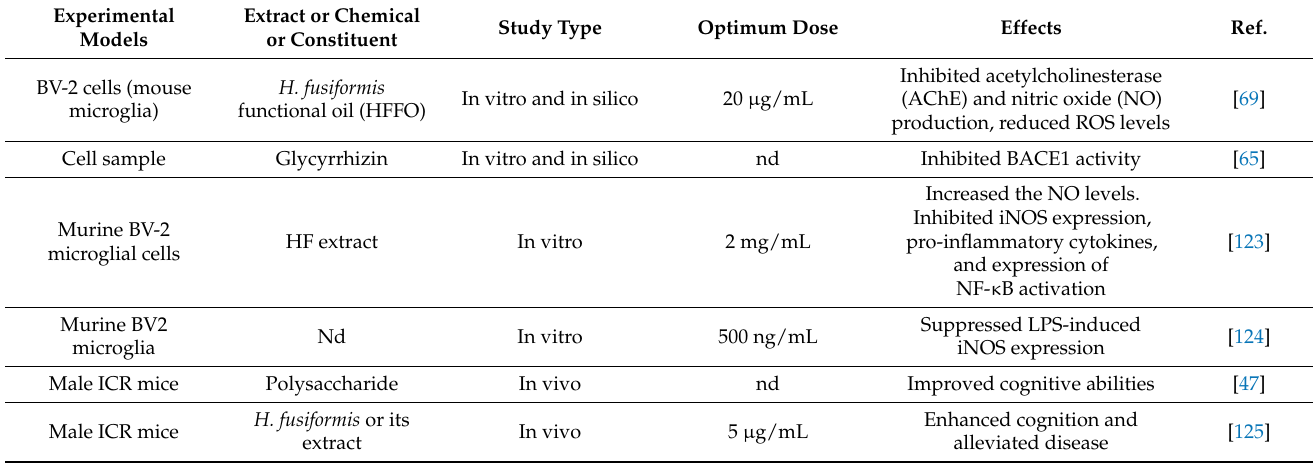
Table 10. Summary of neuroprotective activity of H. fusiformis